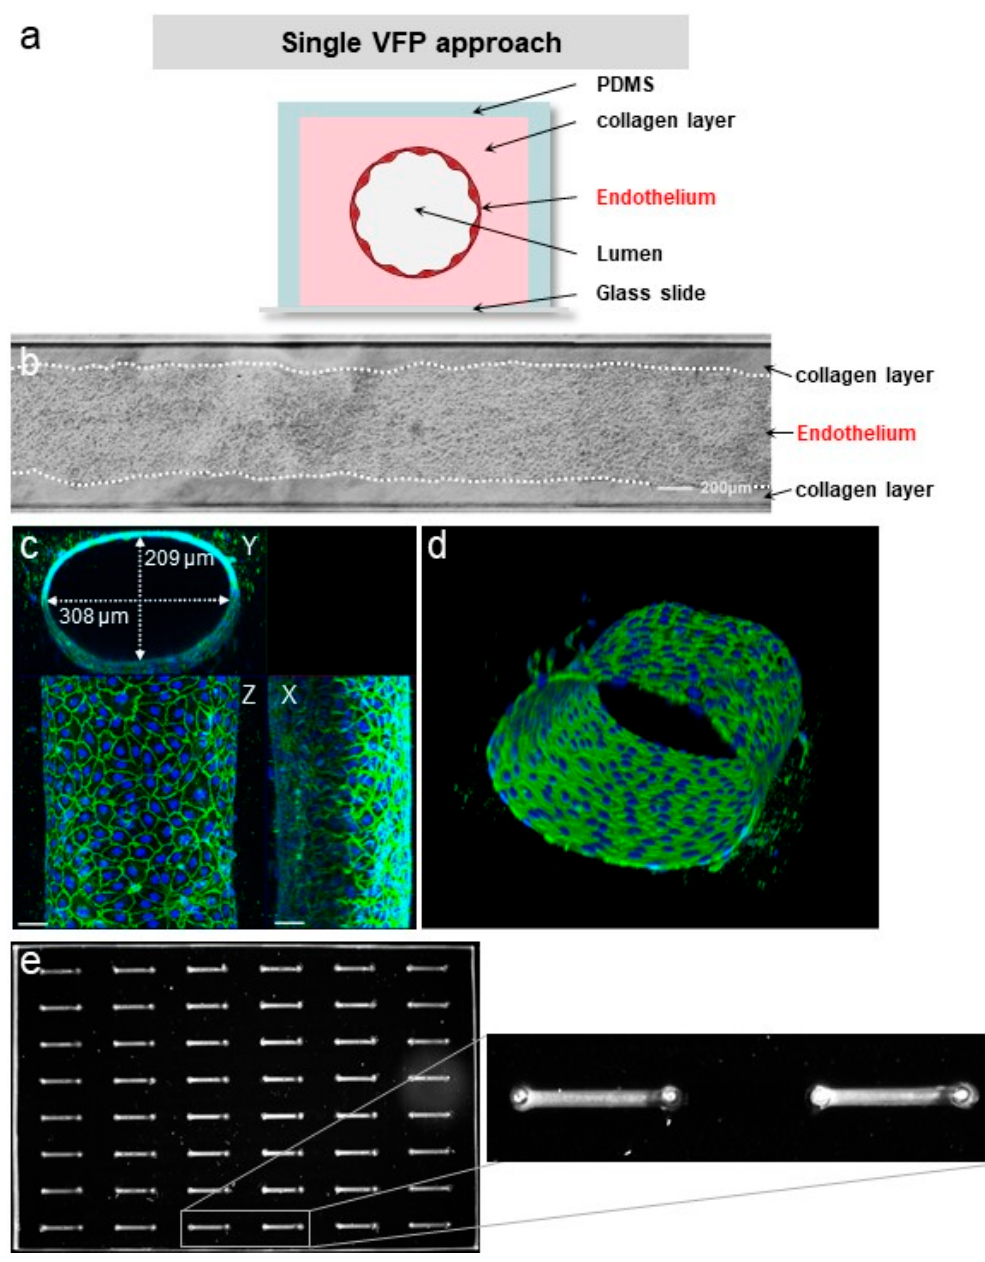
Figure 5. VFP making of blood vessels. ( a ) Principle of vessel construction using VFP (not to scale). ( b ) Phase contrast images of a vessel created by VFP, seeded with HUVEC, bar = 200 µm. ( c ) Confocal images of VoC after immunostaining of the nuclei (DAPI, blue) and of the adherens junction (VE-cadherin, green). Maximum intensity projections of X, Y and Z axis, bar = 50 µ m. ( d ) 3D reconstruction of the VoC shown in ( c ). ( e ) left—Fluorescent imaging of a 48-channel plate where VoC were created by VFP and filled with calcein AM-labeled cells for illustration; right—image magnification of two contiguous